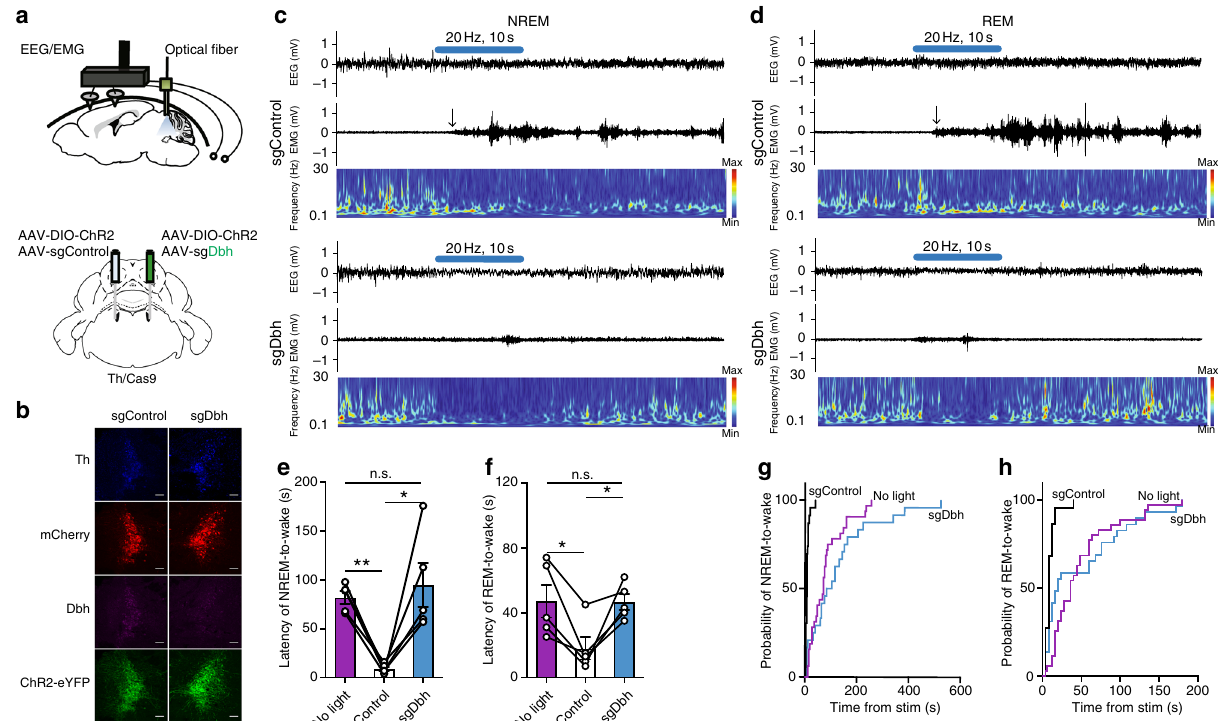
Fig. 3 Disruption of the dbh gene in the LC blocks light-activated ChR2-evoked sleep-to-wake transitions. a Schematic of viral injection into the LC, as de fi ned in the Allen Reference Atlas 26 , and implantation of an EEG/EMG device and optic fi bers. b Representative immuno fl uorescence images of the LC from Th/Cas9 mice injected with AAV-DJ sgControl (left hemisphere) or AAV-DJ sgDbh (right hemisphere) together with AAV-DJ DIO ChR2. Scale bar, 100 μ m. c , d Representative trace of EEG/EMG recordings and the power spectra of EEG (bottom) before and after the unilateral photostimulation (10-ms pulses at 20 Hz for 10 s) of LC neurons in a Th/Cas9 mouse injected with AAV-DJ sgControl (left hemisphere) and AAV-DJ sgDbh (right hemisphere) in NREM ( c ) or REM sleep ( d ). Arrow, the onset of sleep-to-wake transition. e , f Latencies (mean ± s.e.m) to wake during NREM ( e ) or REM ( f ) sleep following the unilateral photostimulation (10-ms pulses at 20 Hz for 10 s) of LC neurons in a Th/Cas9 mouse injected with AAV-DJ sgControl (left hemisphere) and AAV-DJ sgDbh (right hemisphere) together with AAV-DJ DIO ChR2 ( n = 5; mean latency of 6 – 8 stimulations per each mice are